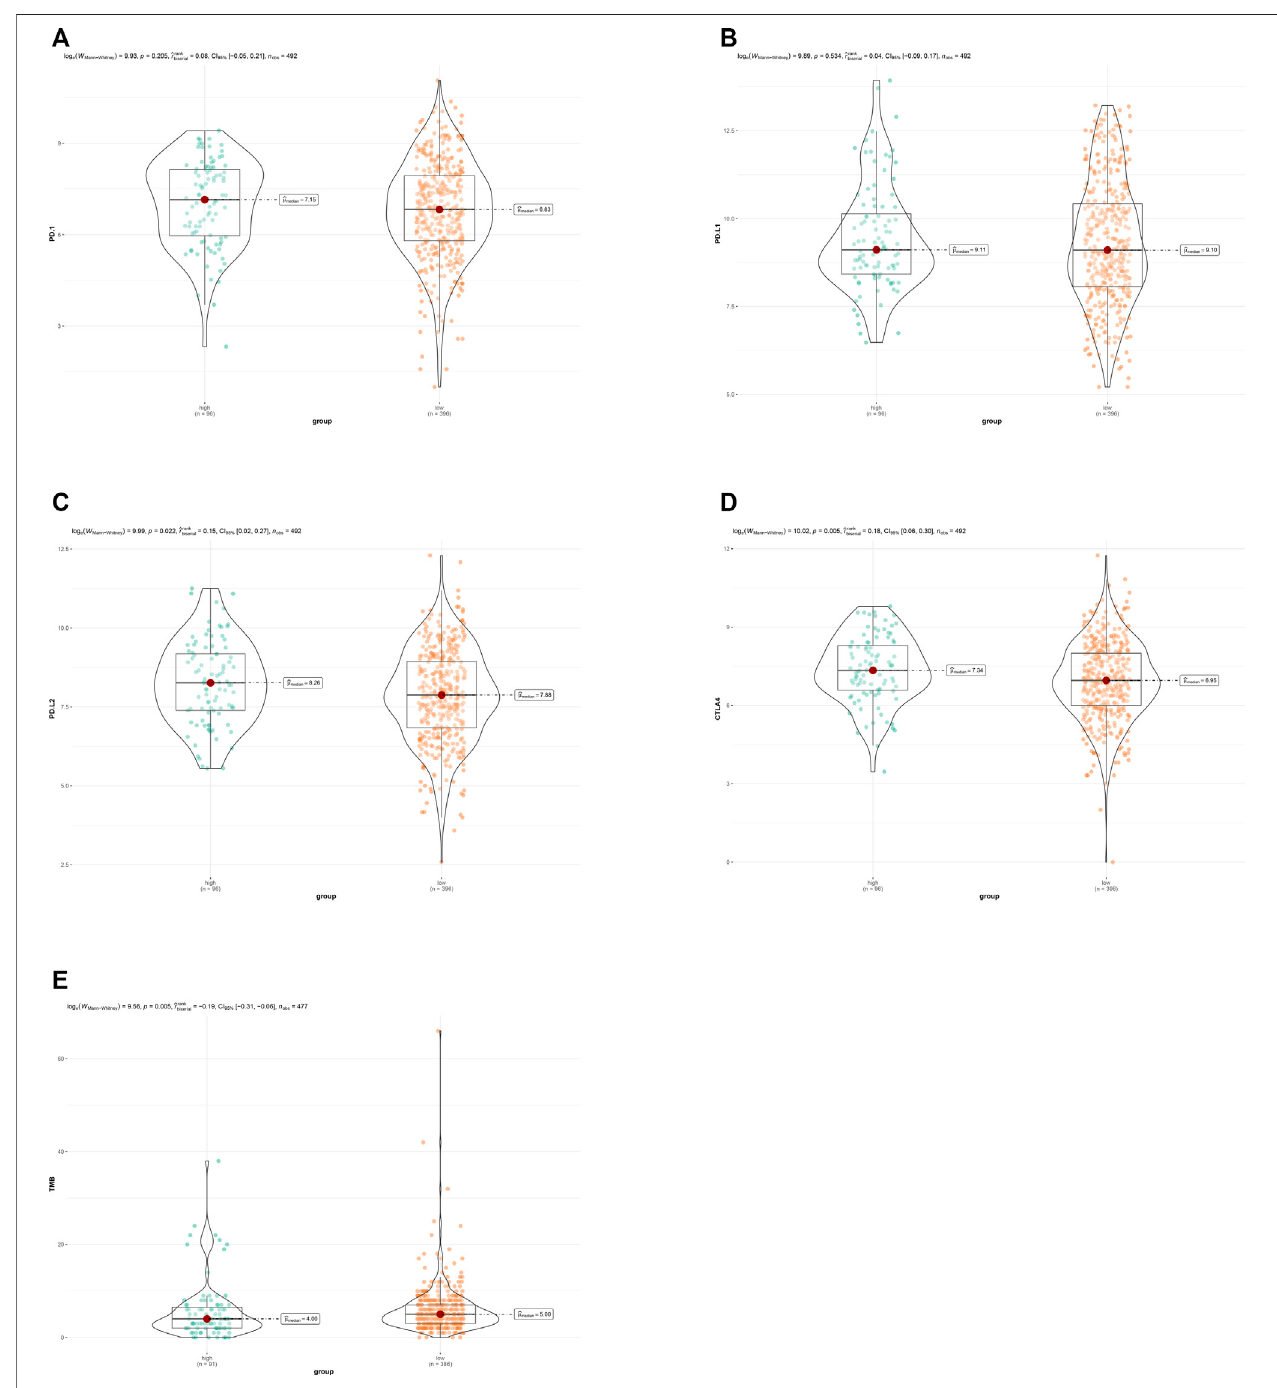
FIGURE7|(A) ExpressionofPD-1betweenthelow-andthehigh-riskgroups. (B) ExpressionofPD-L1betweenthelow-andthehigh-riskgroups. (C) Expression of PD-L2 between the low- and the high-risk groups. (D) Expression of CTL4 between the low- and the high-risk groups. (E) TMB between the low- and the high-risk